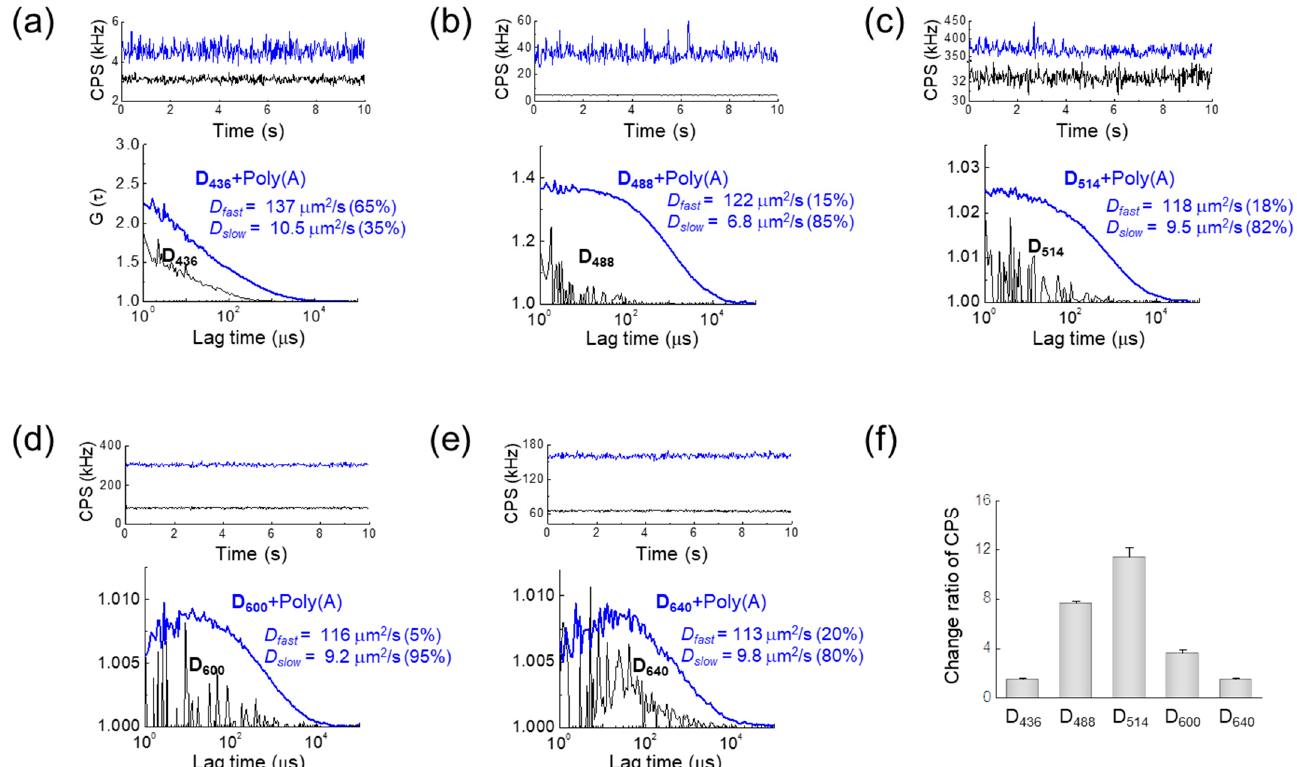
Figure 2. Detection of DNA probe hybridization with poly(A) oligomers by fluorescence correlation spectroscopy for the ( a ) D 436 , ( b ) D 488 , ( c ) D 514 , ( d ) D 600 , and ( e ) D 640 probes. The subscripts indicate the principal excitation wavelength (nm). (top) Representative averaged fluorescence intensity traces (CPS; kHz) for D nnn probes alone (black) and hybridized to poly(A) oligomer (blue). (bottom) Fluorescence correlation function G ( τ ) between the different dyes before (black) and after (blue) hybridization. The mean diffusion coefficients ( D fast and D slow ) of the free D nnn probe and hybridized D nnn complex with poly(A) oligomer are also shown (inset). ( f ) Ratio of averaged fluorescence intensity after and before hybridization for each D nnn probe.